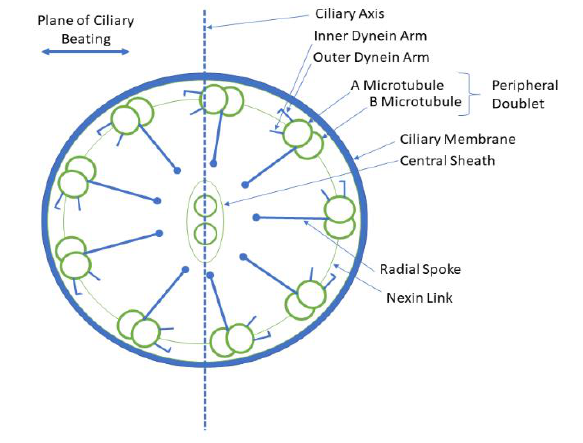
Figure 1. Ciliary Ultrastructu-re. A transverse section of a normal cilium is depicted in this dia- gram showing the internal ultrastructure and the ciliary axis used to identify cilia orientation with respect to each other. The central core or axoneme is surrounded by a ciliary membrane and has nine peripheral microtubule dou-blets associated with two single central microtubules.